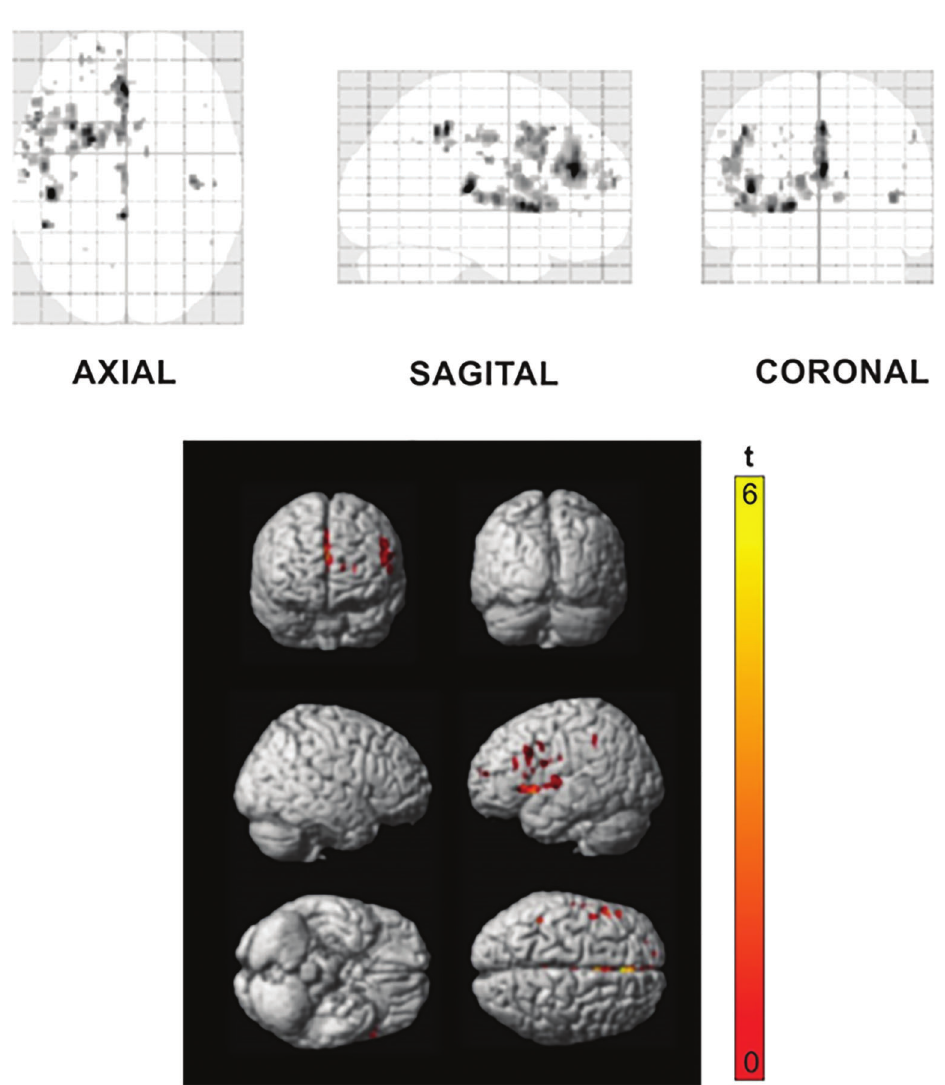
Figure 4. Statistical Parametric Map of differences in regional cerebral blood fl ow (CBF) between young and elderly adults under normocapnia. The colormap indicates brain regions where CBF is higher in young adults compared to the elderly adults (P o 0.001, t -test uncorrected for multiple comparisons). Table 1. Pulsed arterial spin labeling (ASL) and blood oxygenation level-dependent (BOLD) contrast results from gray matter in hypercapnic condition.